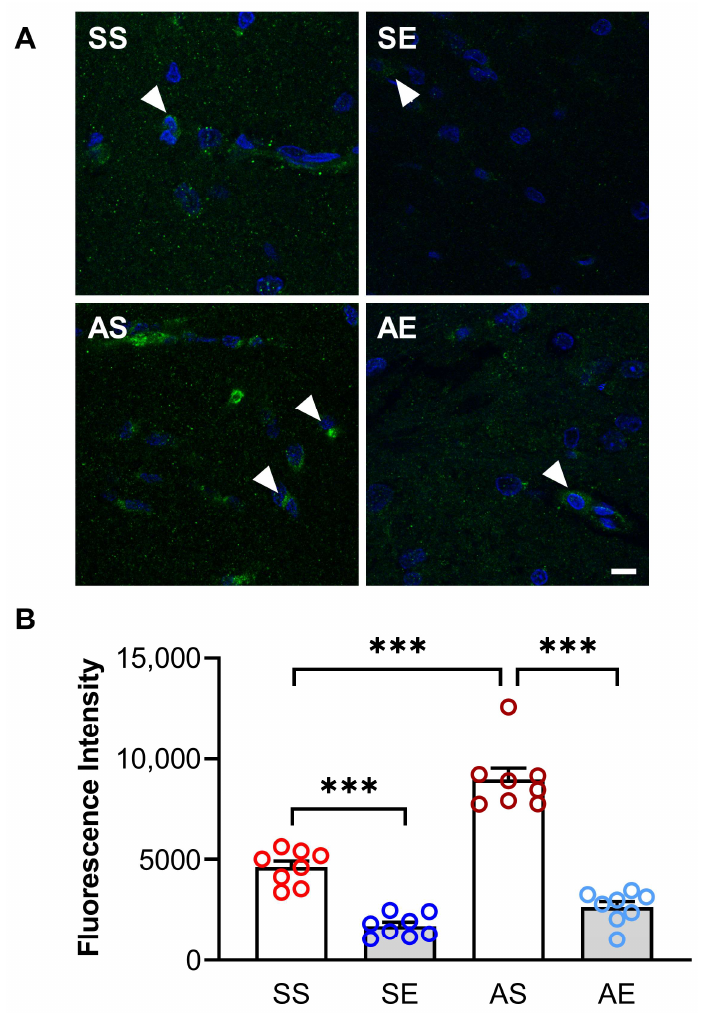
Figure 5. Treadmill exercise decreased the AIE-induced increase in CD68 in the hippocampus of young adult rats. ( A ) Representative microscope imaging of CD68 immunofluorescence staining in the hippocampus of rats in each group. The positive staining of CD68 is marked by white arrowheads. Scale bar = 10 µ m. ( B ) The fluorescence intensity of CD68 in the hippocampus of rats in each group. The expression of CD68 was decreased in the SE rats compared to the SS rats. The expression of CD68 was increased in the AS rats compared to the SS rats. The increased expression of CD68 in AIE rats was prevented by treadmill exercise training (*** p < 0.001, n =